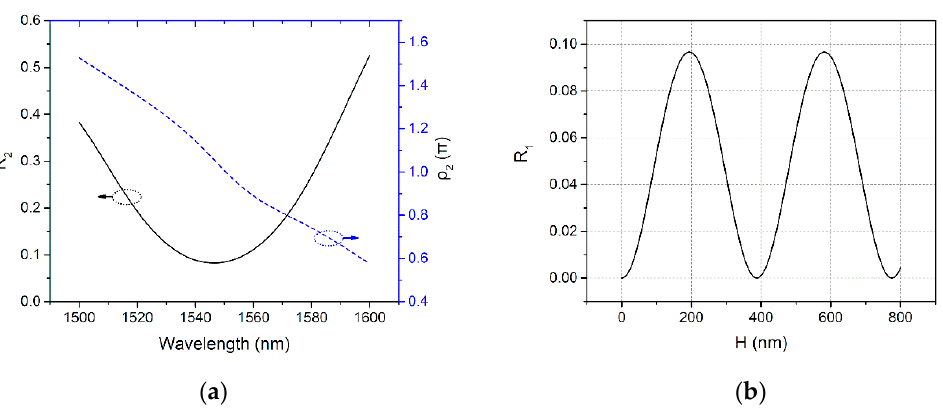
Figure 4. ( a ) Calculated R 2 and ρ 2 as a function of wavelength; ( b ) Calculated R 1 with various H .